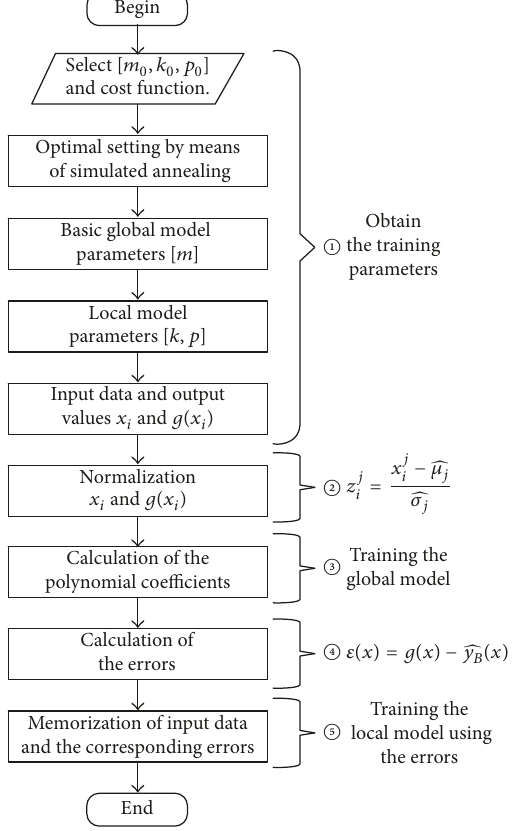
Figure 2: Diagram of the procedure for training hybrid incremental model.